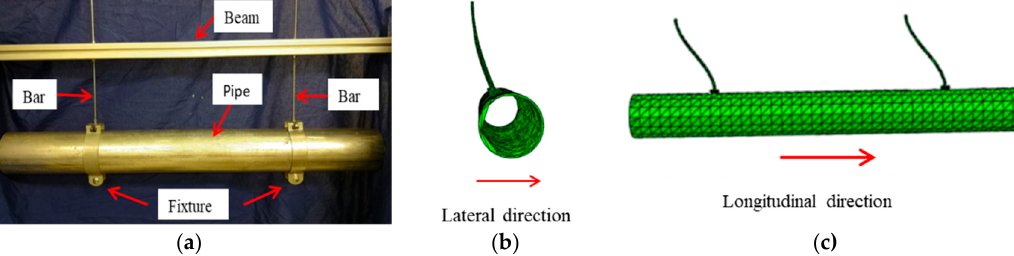
Figure 3. Piping system model and its finite element model: ( a ) Suspended piping system; ( b ) first vibration mode shape; ( c ) second vibration mode shape.